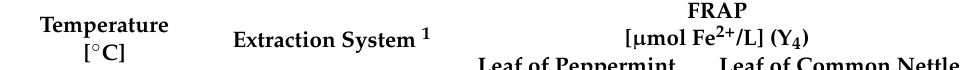
Table 4. FRAP antioxidant activity for extracts from peppermint and common